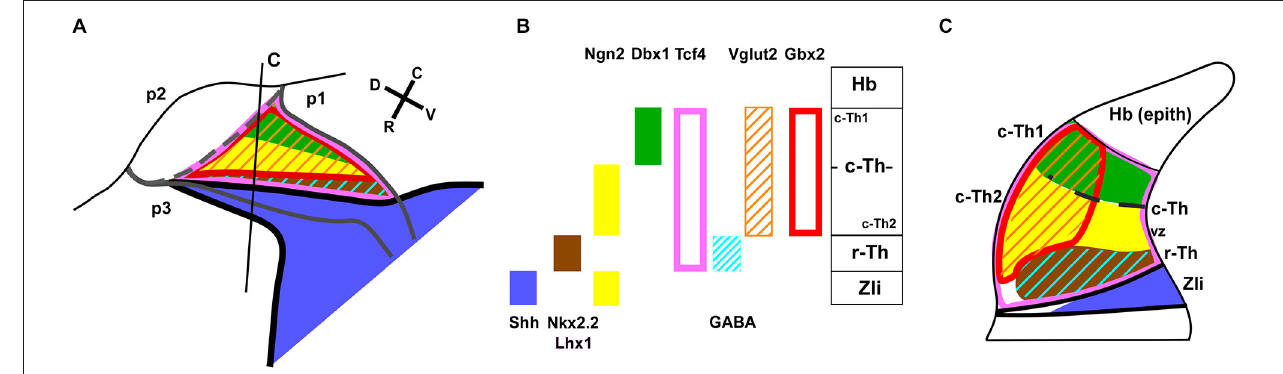
which a color-code for the distinct expression patterns for the markers used is depicted in (B) . (C) corresponds to the representation of a transverse section at the level indicated in (A) in which the extent of the thalamic progenitor domains is indicated in relation to the